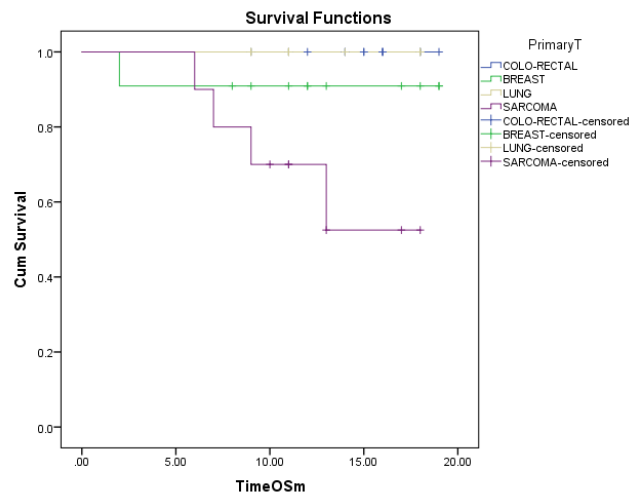
Figure 6. Overall survival of the first four most frequent types of cancers from the lot of